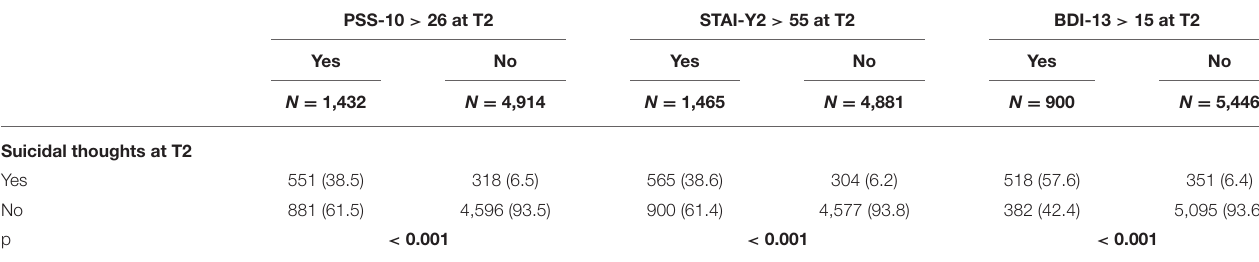
TABLE 4 | Association between suicidal thoughts and severe symptoms of stress, anxiety and depression at T2 ( n = 6,346): results of the bivariate analyses. PSS-10 > 26 at